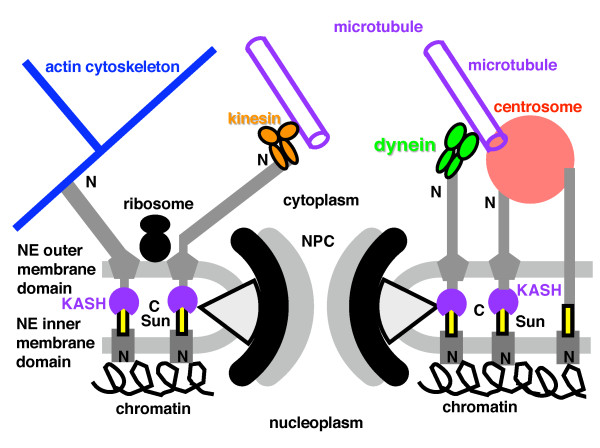
Role of Sun-domain and KASH-domain proteins in nuclear envelope architecture. Sun-domain proteins embedded in the inner membrane attach it directly to the DNA surface of the peripheral heterochromatin (the nucleoskeleton). Their Sun-domains (yellow) bind to the KASH domains (purple) of proteins embedded in the outer membrane, which attach it to the cytoplasmic actin filaments, microtubules, and centrosome of the cytoskeleton. Grey pentagons represent the membrane spanning domain(s) of the KASH-domain proteins and grey rods their flexible cytoskeleton-binding N-terminal domains, which differ greatly among the various types. Microtubules may be attached to KASH-domain proteins either by kinesin or dynein motors. The firm Sun-KASH linker complex (known as LINC) within the perinuclear cisterna holds the inner and outer membrane domains of the NE together with the correct spacing and transmits mechanical forces from cytoskeleton to nucleoskeleton or vice versa without damaging it. Some eukaryotes, e.g. animals, lobose amoebae and peridinean dinoflagellates, (probably polyphyletically) evolved a proteinaceous lamina beneath the inner membrane to further strengthen the nuclear periphery, but this was probably absent in the first eukaryotes; additionally to the universal interactions shown, in animals only cytoplasmic intermediate filaments (IF) attach to KASH proteins via plectin adaptors and lamin IF proteins associate with the intranuclear domain of Sun proteins. For simplicity the fact that Sun-domain proteins are homodimers with a coiled coil domain between their two membrane-spanning and chromatin binding domains (lumped here as grey rectangles) and two Sun domains is not depicted.